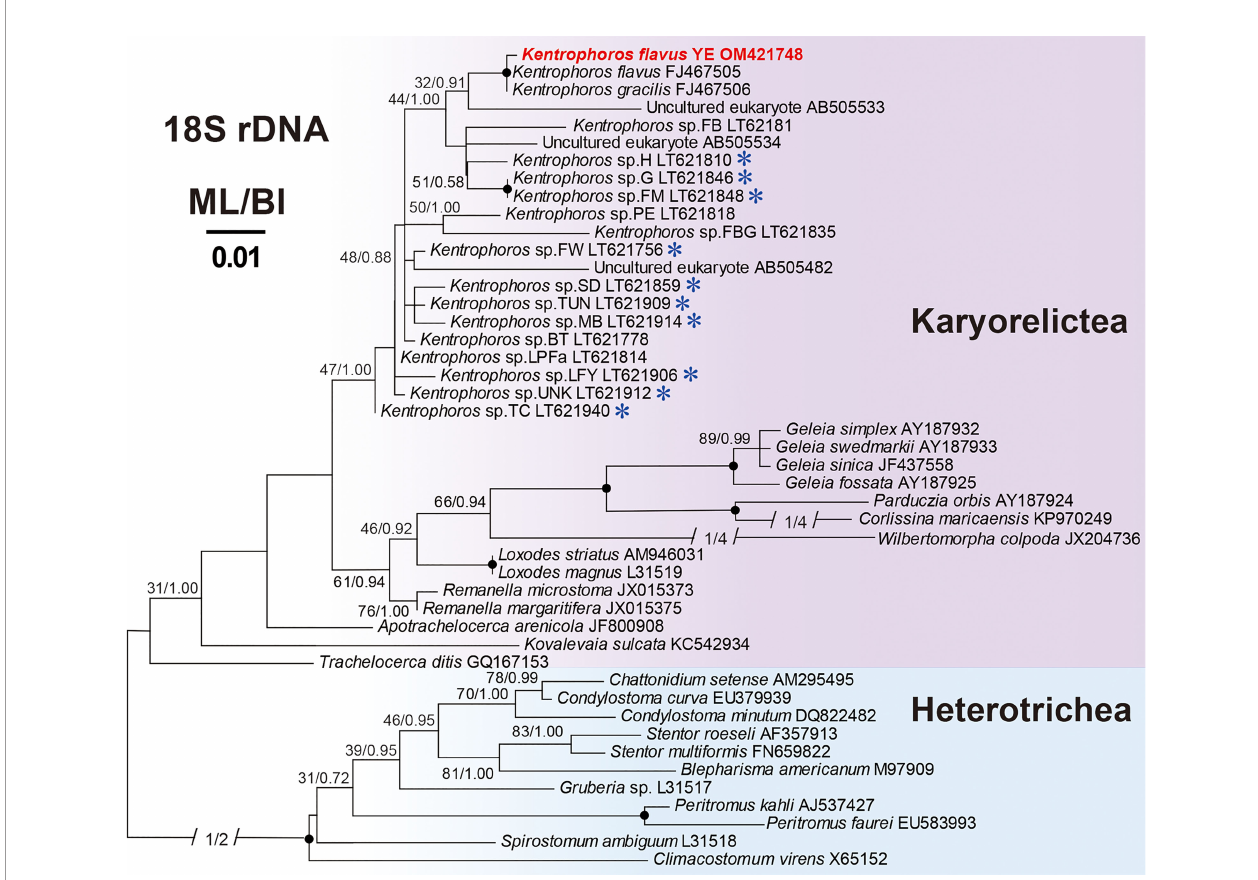
FIGURE 2 | Maximum likelihood (ML) tree based on the 18S rRNA genes showing the positions of Kentrophoros fl avus YE (in red) with a GTR + I + Г model. The numbers on the nodes represent the bootstrap values of the ML and the posterior probability of the Bayesian inference (BI). The black dot on the node represents the bootstrap value >95%. The species marked with blue asterisks have been reported with thiotrophic ectosymbionts. GenBank accession numbers are given following the species names. All branches are drawn to scale.